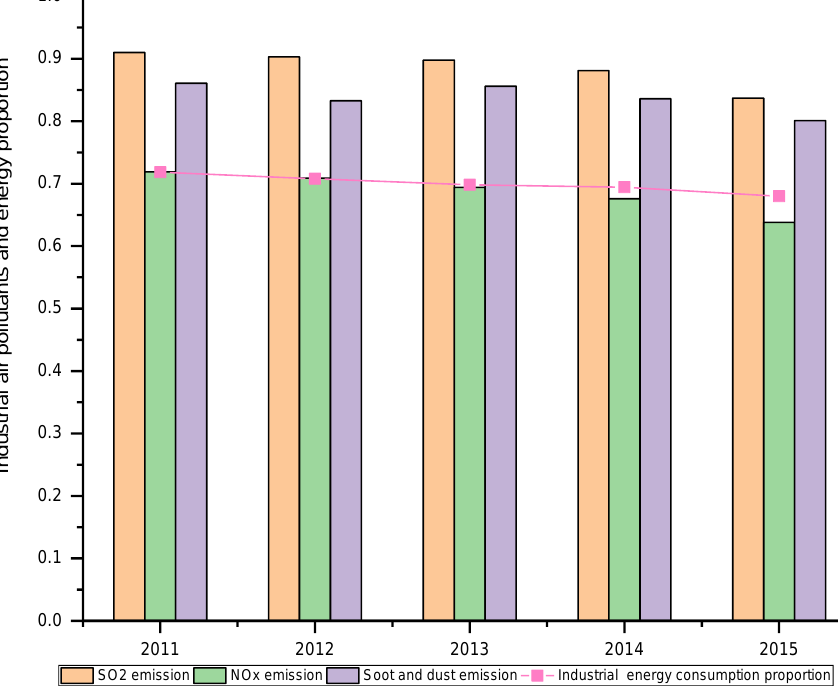
Figure 1. proportion of industrial waste gas. Figure 1. Proportion of industrial waste